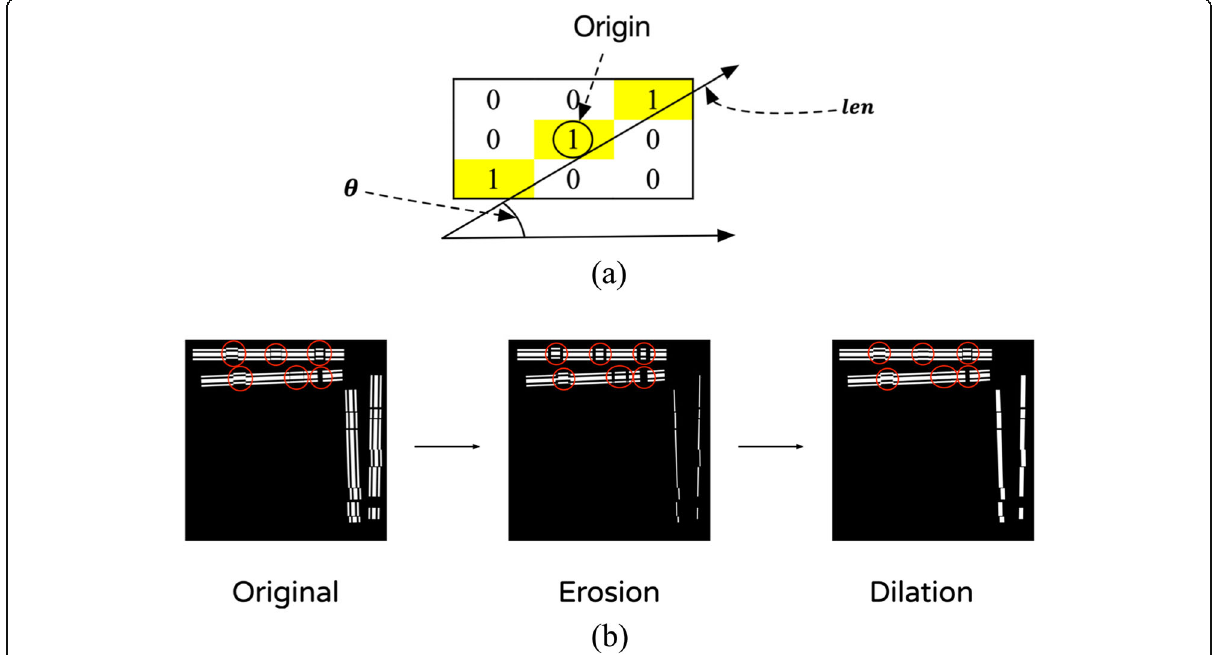
Fig. 3 Application of a a line-structuring element to b the erosion and dilation